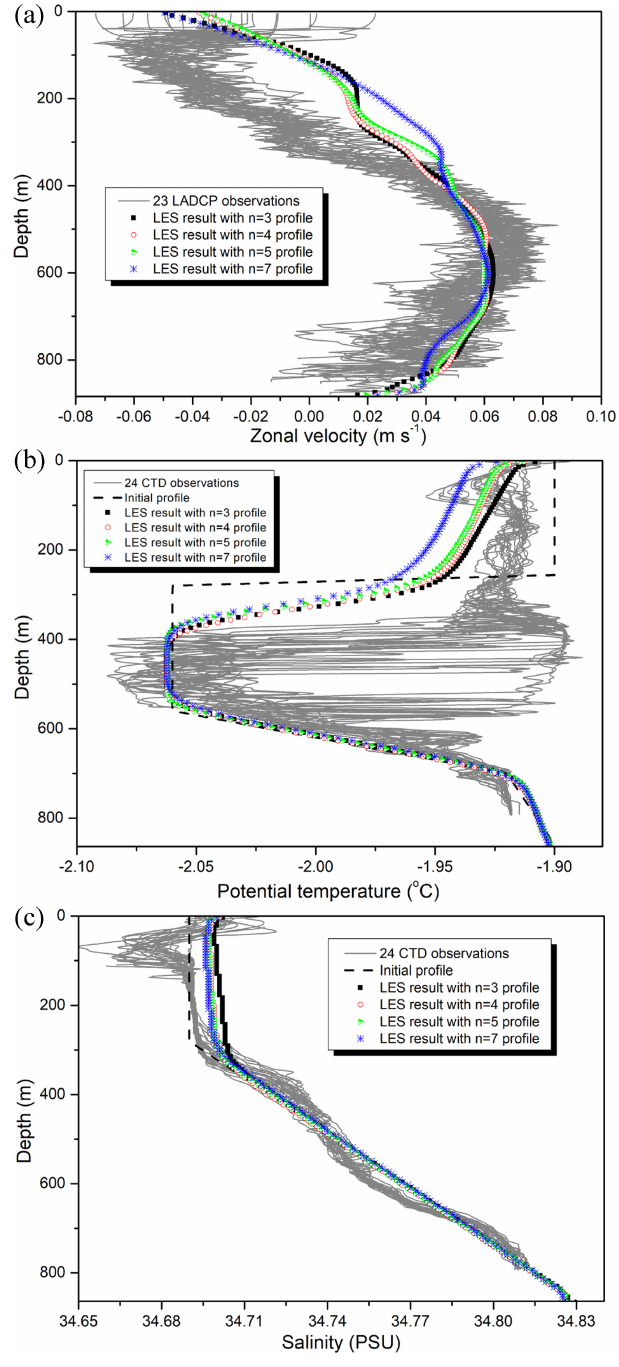
Figure 5. Vertical profiles of the velocity, potential temperature, and salinity obtained from the CTD and LADCP observational data (solid grey lines), initial profiles (black dashed line), and the results of the large-eddy simulation (LES). (a) Zonal velocity; (b) Potential temperature; (c)